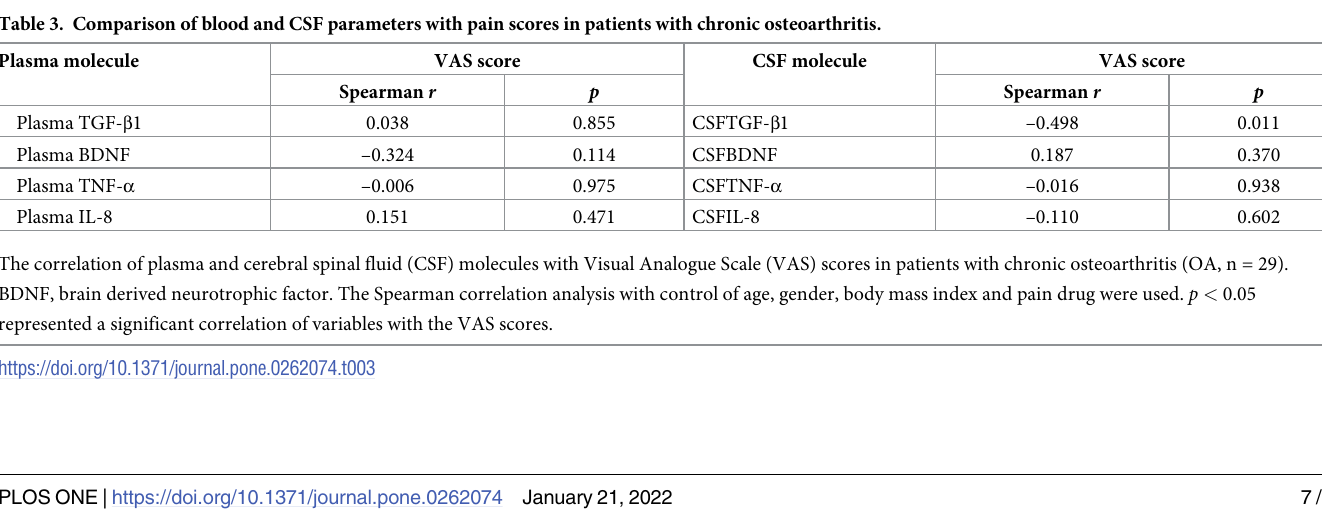
Table 3. Comparison of blood and CSF parameters with pain scores in patients with chronic osteoarthritis. Plasma molecule